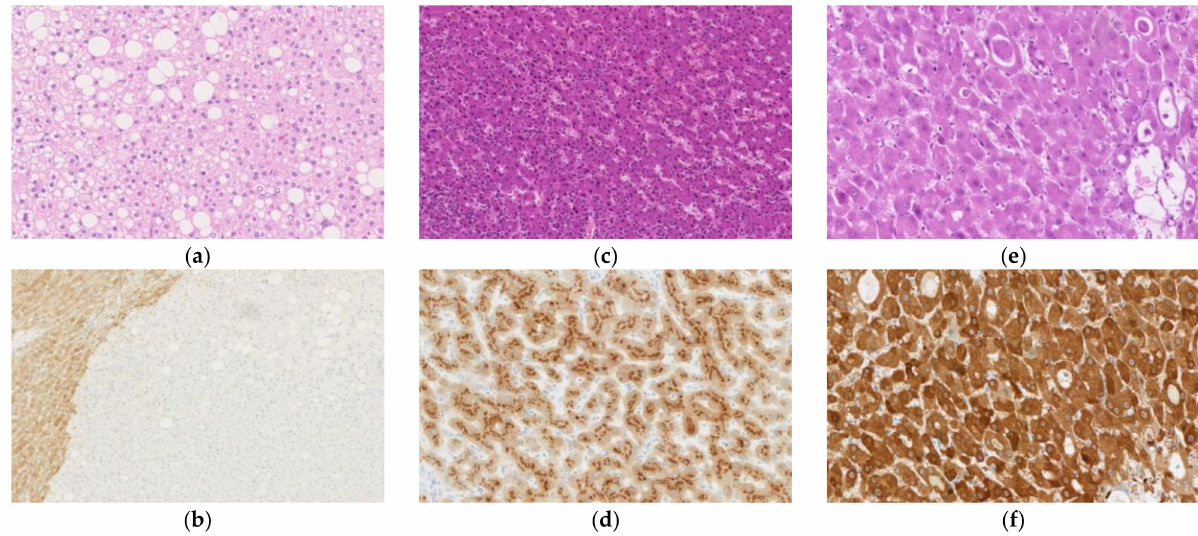
Figure 3. Histological appearance ( a , c , e ) and results of immunohistochemical staining ( b , d , f ) of hepatocellular adenoma (HCA). ( a ) Hepatocyte nuclear factor (HNF) 1A -inactivated HCA (H-HCA) shows prominent steatosis. ( b ) Immunohisto- chemical staining for liver fatty acid-binding protein is negative in the H-HCA lesion but positive in the surrounding liver tissue. ( c ) Inflammatory HCA (IHCA) is characterized by sinusoidal dilation and patchy inflammatory cell infiltration. ( d ) On immunohistochemistry, tumor cells of IHCA are positive for serum amyloid A. ( e ) β -catenin-activated HCA (b-HCA) may be associated with cellular and structural atypia, and pseudoglands may be observed. ( f ) b-HCAs with CTNNB1 gene mutations that lead to strong β -catenin pathway activation show a strong/homogenous staining pattern for GS. (Original magnification: × 150 for ( a , d ), × 100 for ( b , c ), and × 200 for ( e , f